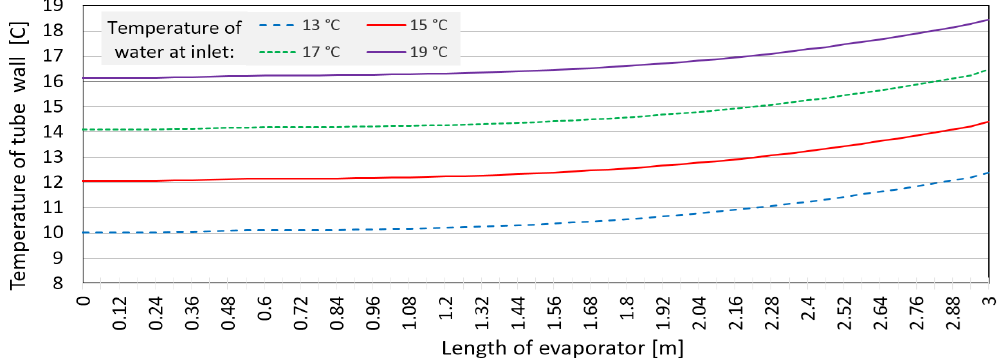
Figure 3. Variation of the temperature of the water.